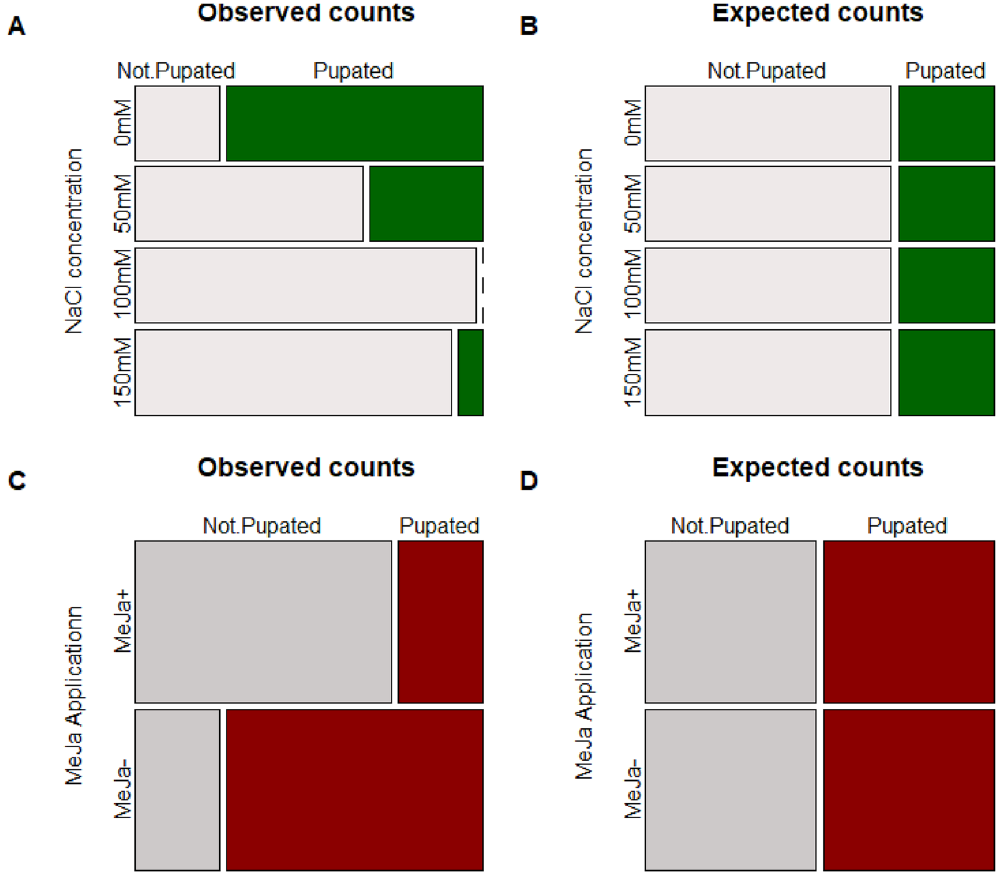
Figure 4. Effects of four different NaCl concentrations (0 mM, 50 mM, 100 mM, or 150 mM) on the ( A ) observed counts and ( B ) calculated expected frequencies of pupated Spodoptera exigua larva after 200 h on an assigned diet. Effects of plant induction via exogenous application of methyl jasmonate on the ( C ) observed counts and ( D ) calculated expected frequencies of pupated Spodoptera exigua larva after 200 h on an assigned diet.